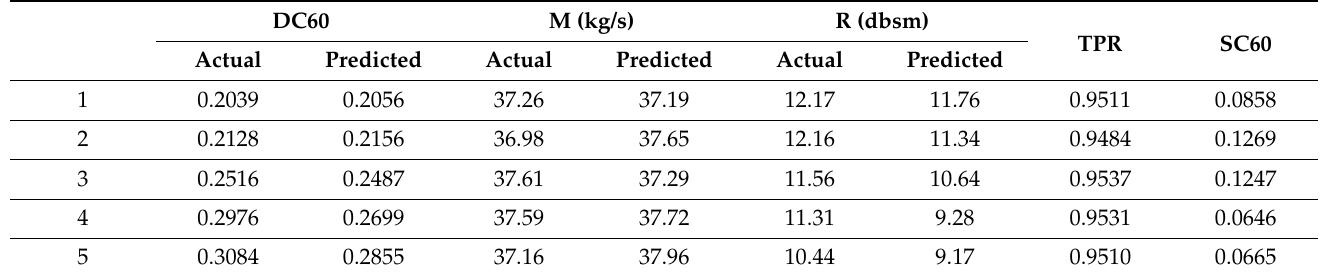
Table 10. Error statistics of performance